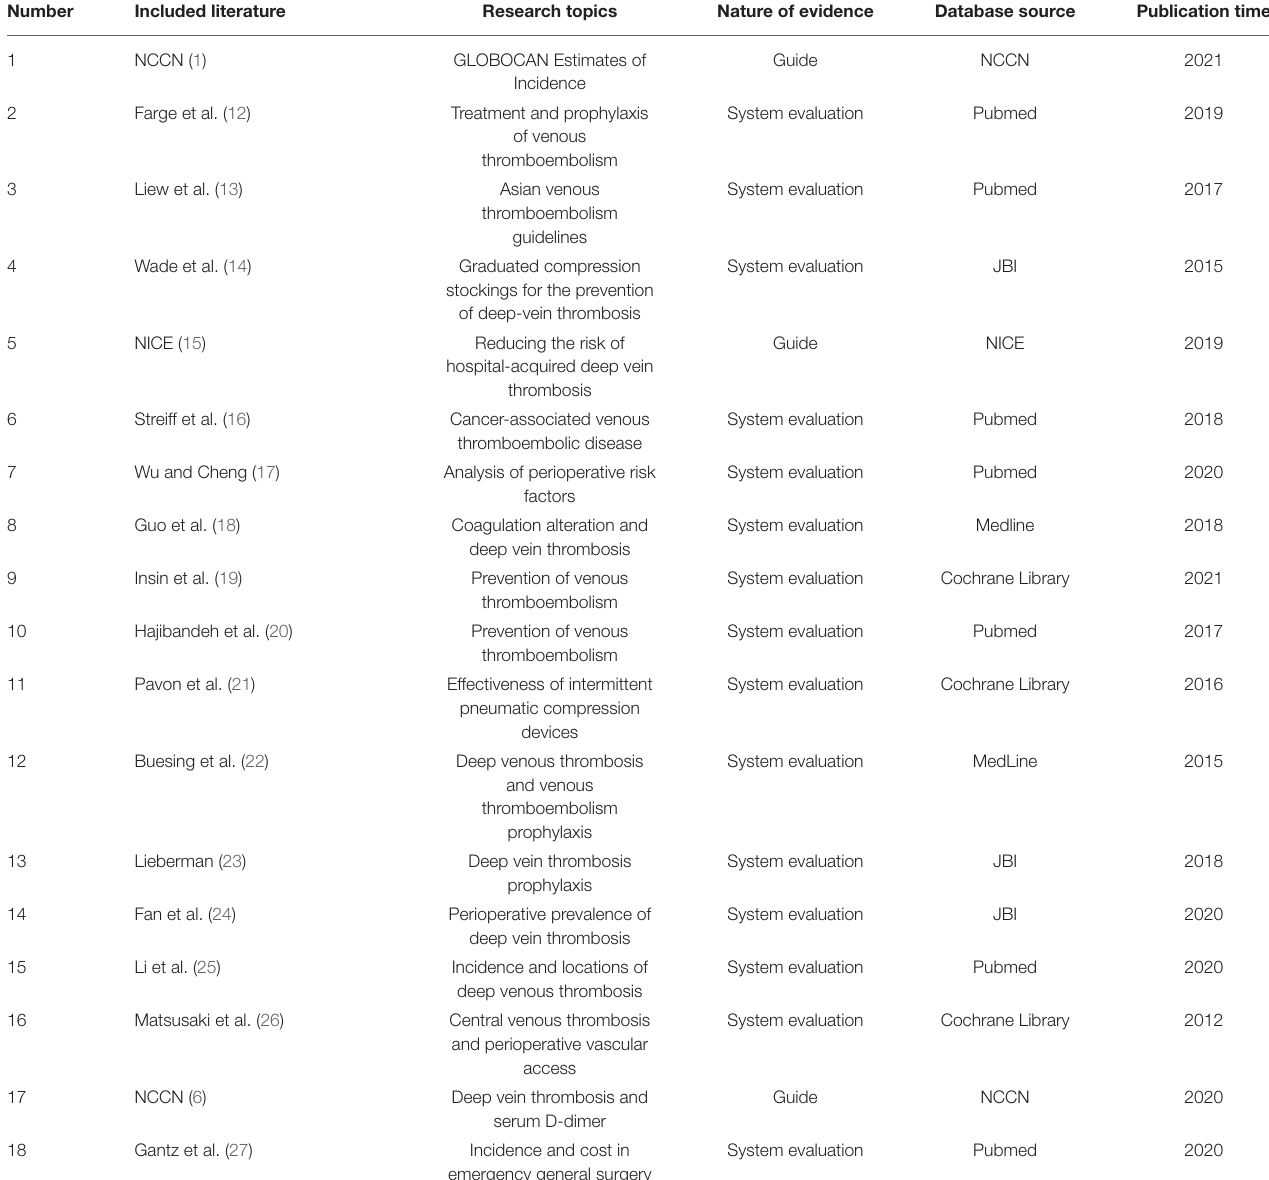
TABLE 1 | General information included in the